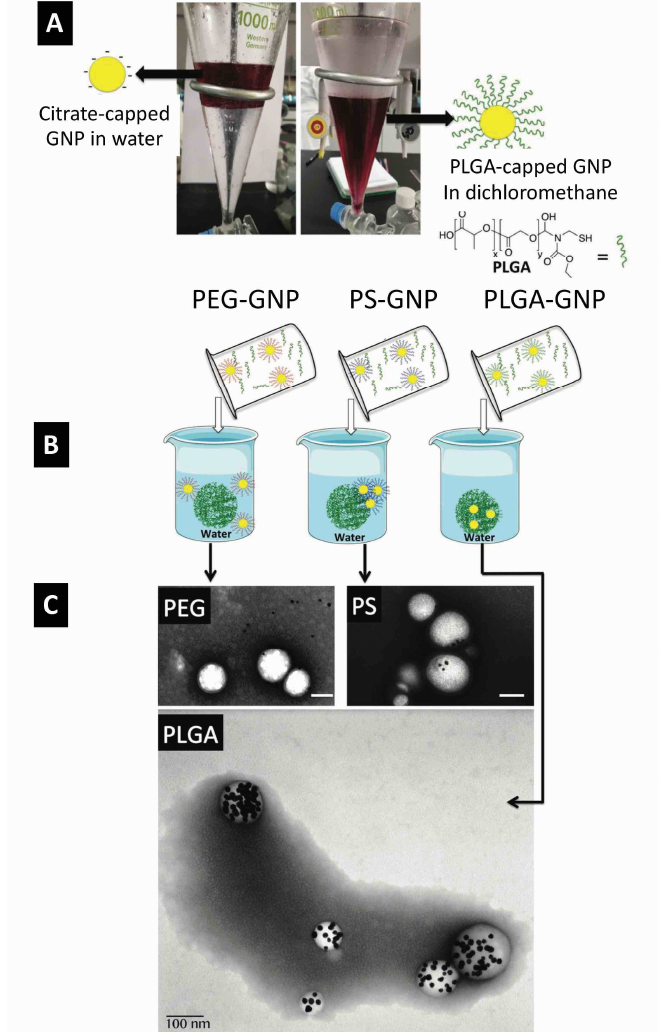
Figure 8. Efficient encapsulation of GNP into poly(lactic-co-glycolic acid) (PLGA) nanoparticles according to the “like dissolves like” principle. ( A ) First, citrate-capped GNP are transferred from water to dichloromethane using PLGA-SH to prepare PLGA-capped GNP that can be re-dispersed in acetone. ( B ) Using the nanoprecipitation method, PEG- or PS- or PLGA-capped GNP are encapsulated into PLGA nanoparticles. ( C ) TEM images conforming the partitioning of PEG-GNP into the aqueous external phase, the poor encapsulation of PS-GNP, and the efficient encapsulation of PLGA-GNP into PLGA nanocarriers. Scale bars are 100 nm in all images. Reproduced from Alkilany et al. [28] which is licensed under a Creative Commons Attribution CC BY 4.0 Internalional License.